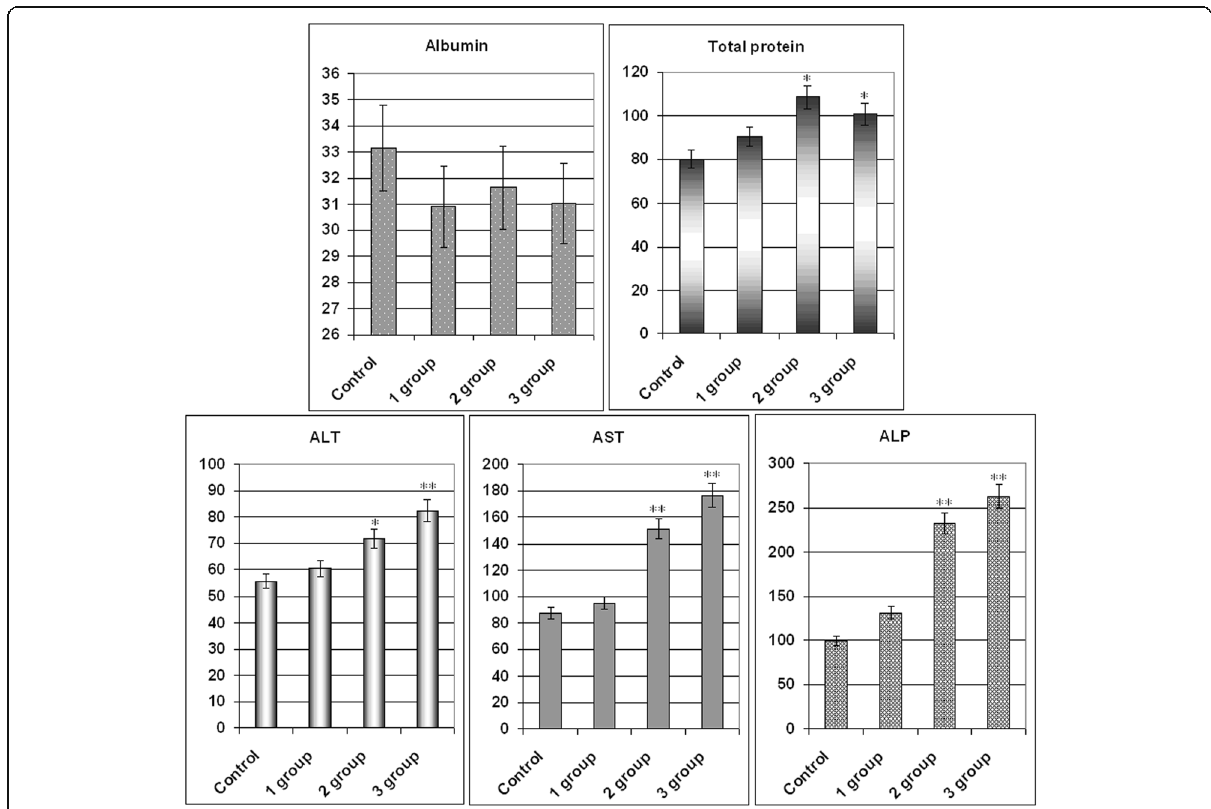
Fig. 9 Monitoring of clinical parameters following CNTox (1 group), CNT-DOX (2 group), free DOX (3 group) administration in Balb/2a mice. Mice were treated by CNTox, CNT-DOX, DOX every 3 days during 4 weeks, in concentrations: CNT — 1.5 g/kg and Dox — 20 mg/kg of weight. Each experiment was done in triplicate. Statistical significance: * р ≤ 0.05 or ** р ≤ 0.01. ALT alanine transferase, AST aspartate transferase,